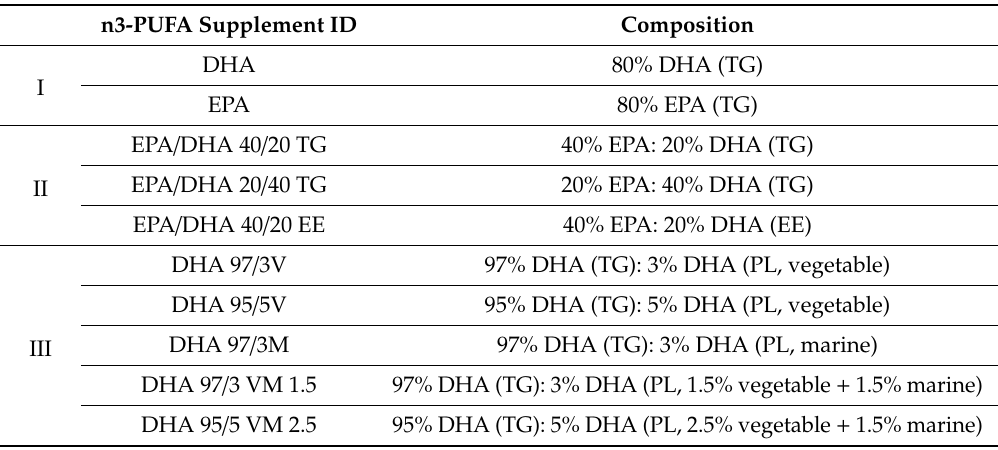
1:1. Images were captured in the Z-stack mode with a laser scanning confocal imaging system (Zeiss LSM-510 Meta, Oberkochen, Germany) using a 40 × objective. Table 1. Composition of the di ff erent groups of n3-PUFA (long-chain n-3 polyunsaturated fatty acids) supplements. All fatty acids (FA) are presented as a percentage of n3-PUFA, the remaining percentage in each group consisted of a non n3-PUFA diluent. EPA: Eicosapentaenoic acid; DHA: Docosahexaenoic acid; TG: Triglycerides; EE: Ethylesters; PL: Phospholipids. n3-PUFA Supplement ID